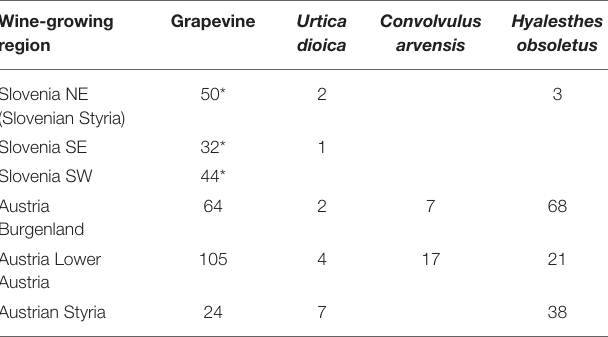
TABLE 1 | The total number of samples included in genotyping by sequencing for different “ Ca . P. solani” hosts. Wine-growing